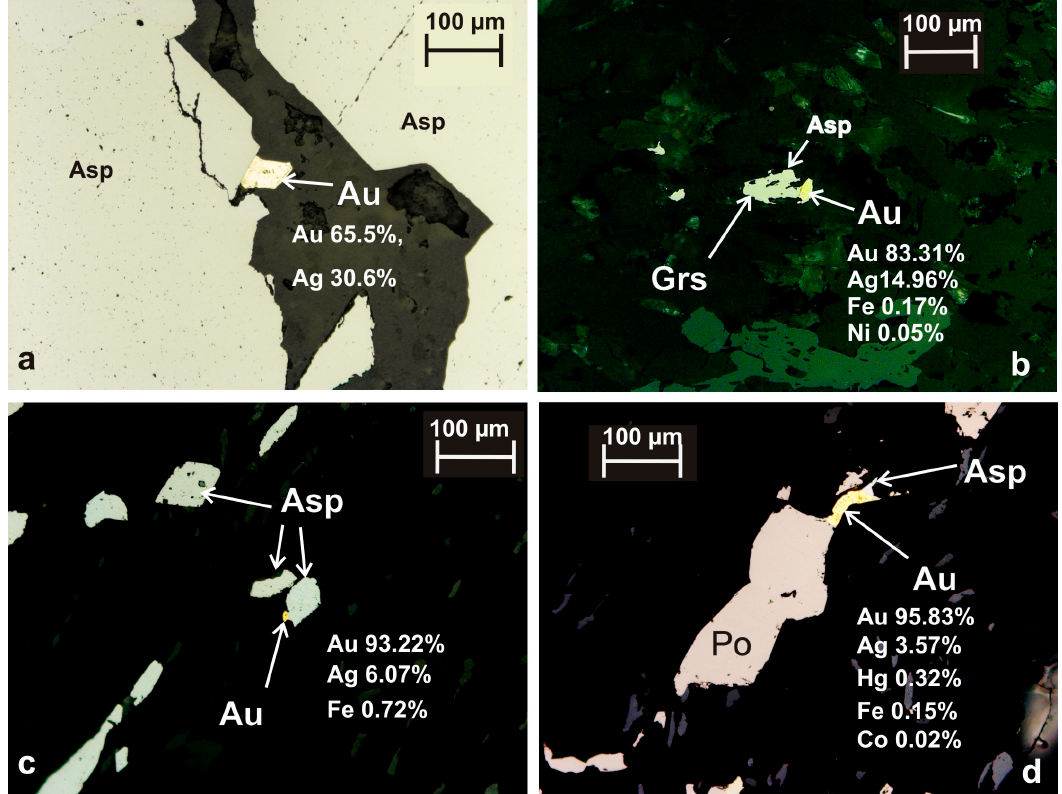
Figure 10. Gold with arsenopyrite and pyrrhotite, polished section photos, reflected light, one polarizer. ( a ) electrum and quarts in a fracture in arsenopyrite, ( b ) gold at the boundary of gersdorfite and silicate minerals, ( c ) gold at the boundary of arsenopyrite and silicate minerals, ( d ) gold with pyrrhotite and arsenopyrite.